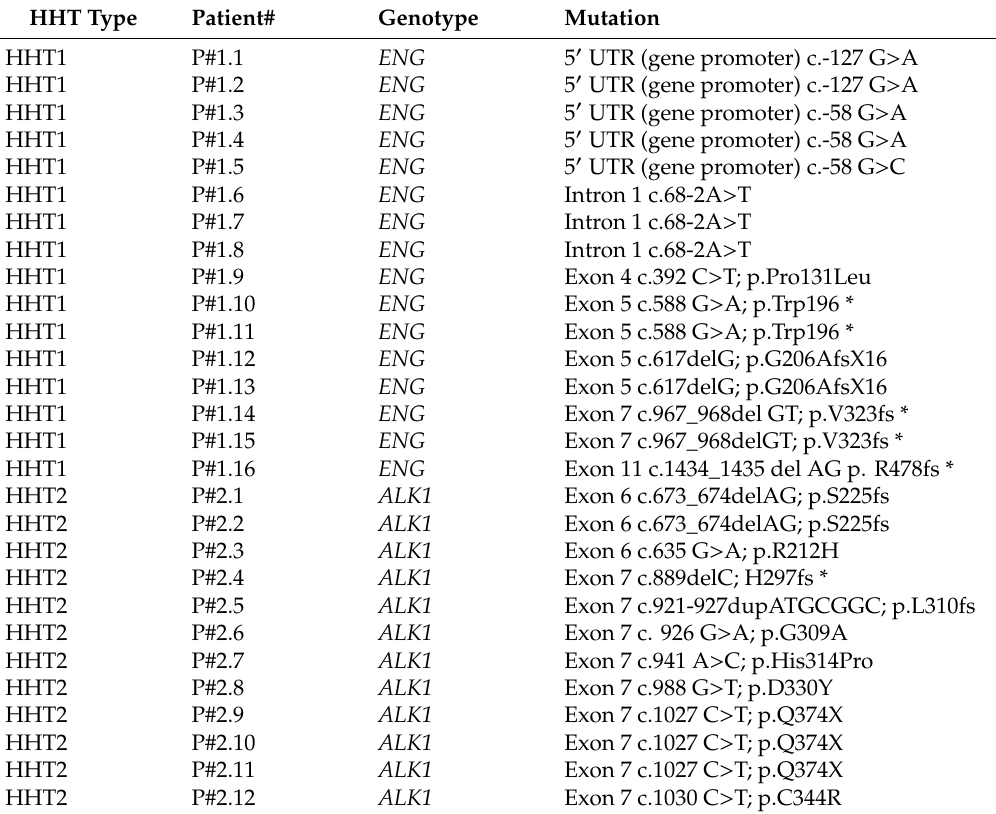
Table 1. Summary of genotypes and mutations of hereditary hemorrhagic telangiectasia (HHT) of patients 1